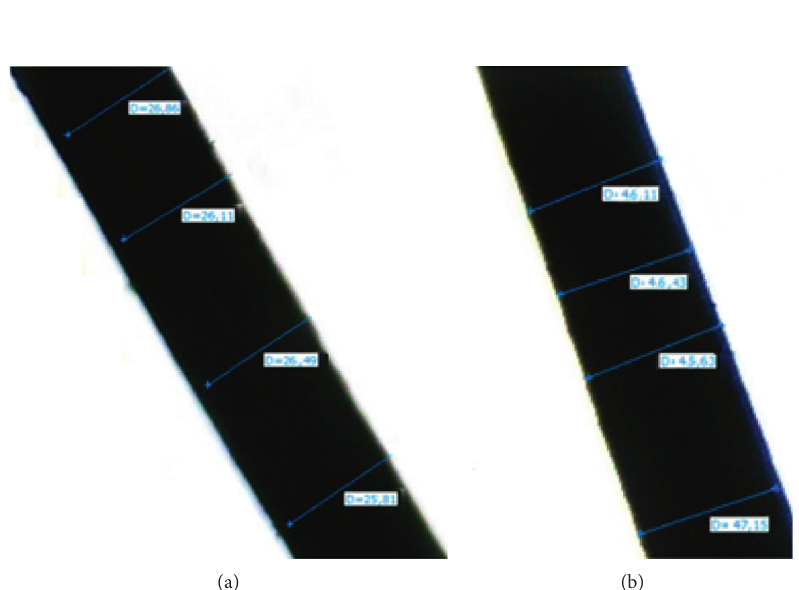
Figure 7: Image of optical microscope of (a) bare cotton fibers and (b) polyaniline-deposited cotton